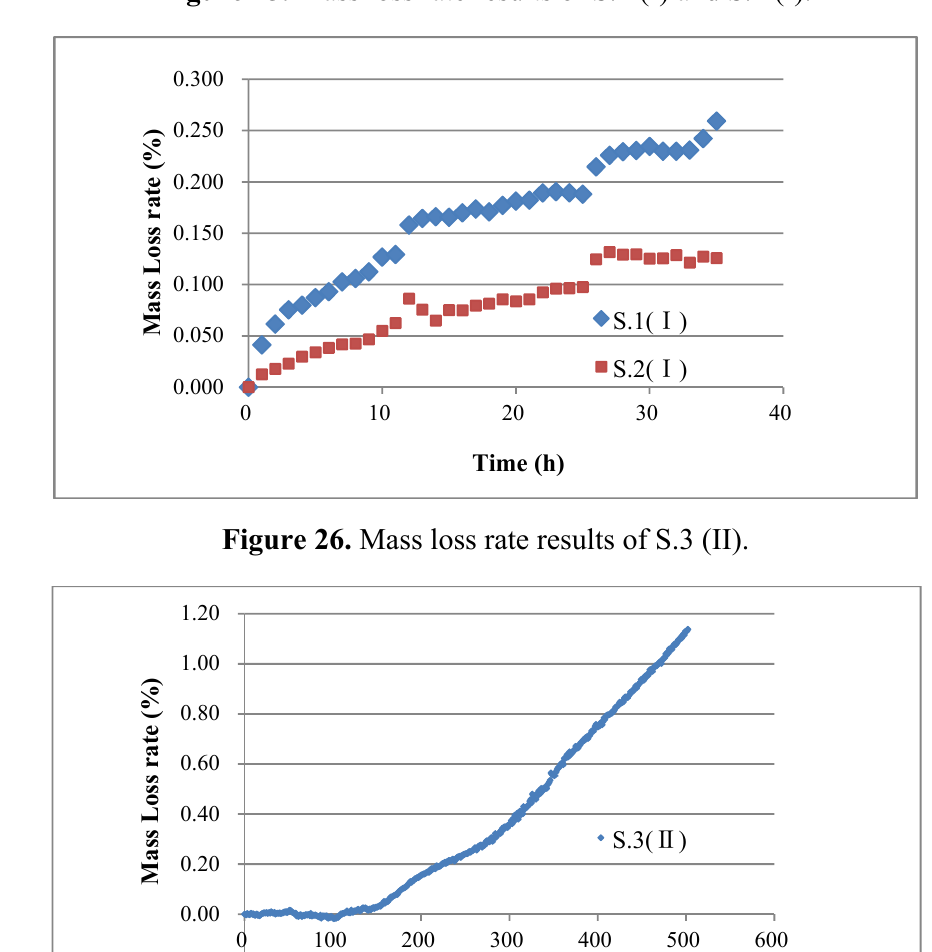
Figure 25. Mass loss rate results of S.1 (I) and S.2 (I).